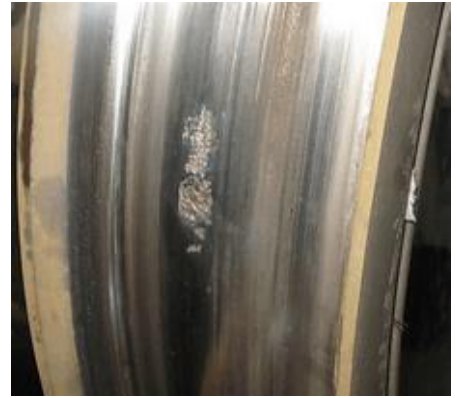
Figure 11. An example of the bogie fault (wheel tread peeling).